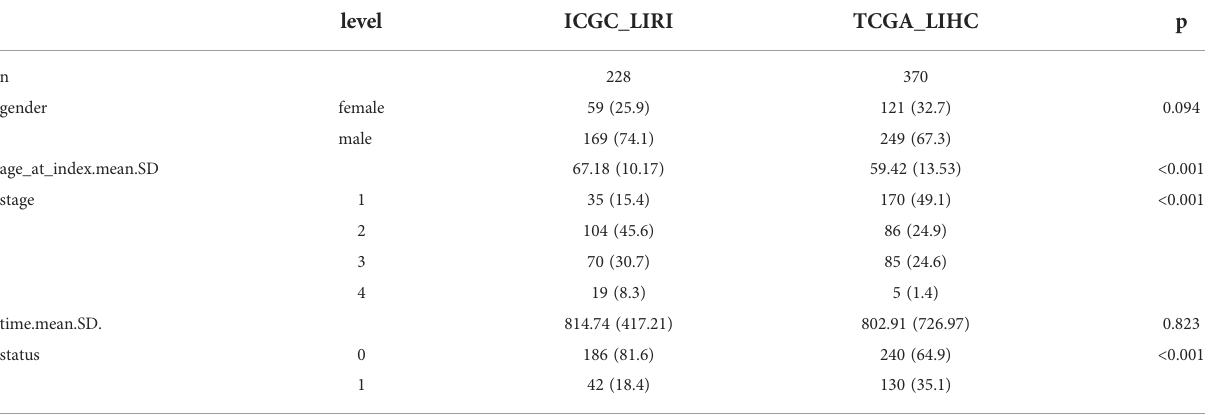
TABLE 1 Demographical and clinical